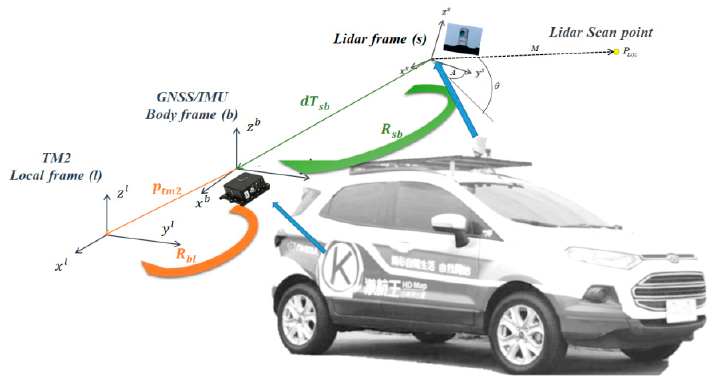
Figure 10. Schematic diagram showing transformations from Lidar frame to local frame.